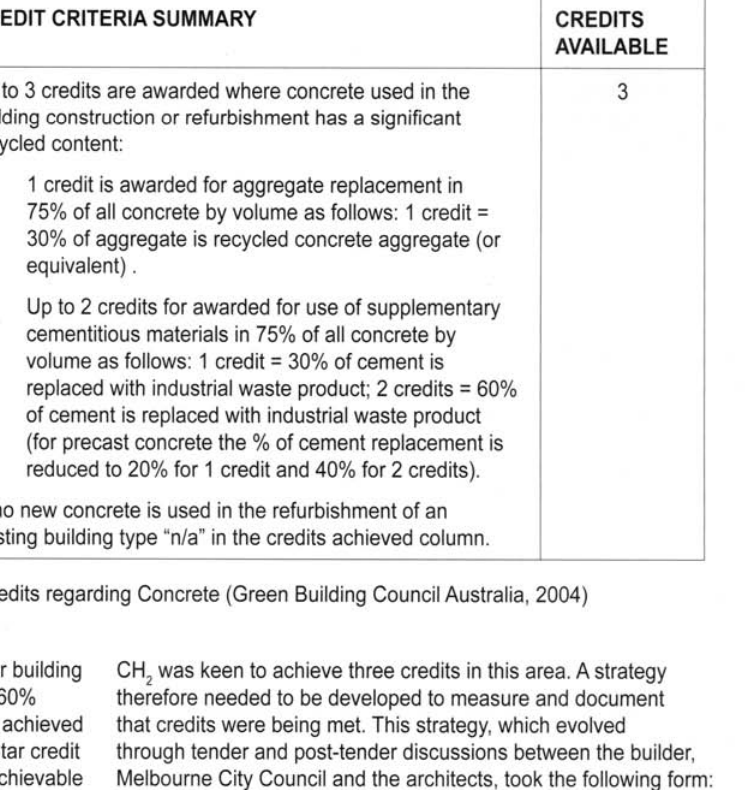
The challenge for the CH team was that while the pioneer building 2 60L (60 Leicester Street, Melbourne) had achieved up to 60% replacement of OPC with supplementaries, this had been achieved in concrete in a low-rise project. Furthermore the Green Star credit for pre-cast concrete was a target that was theoretically achievable